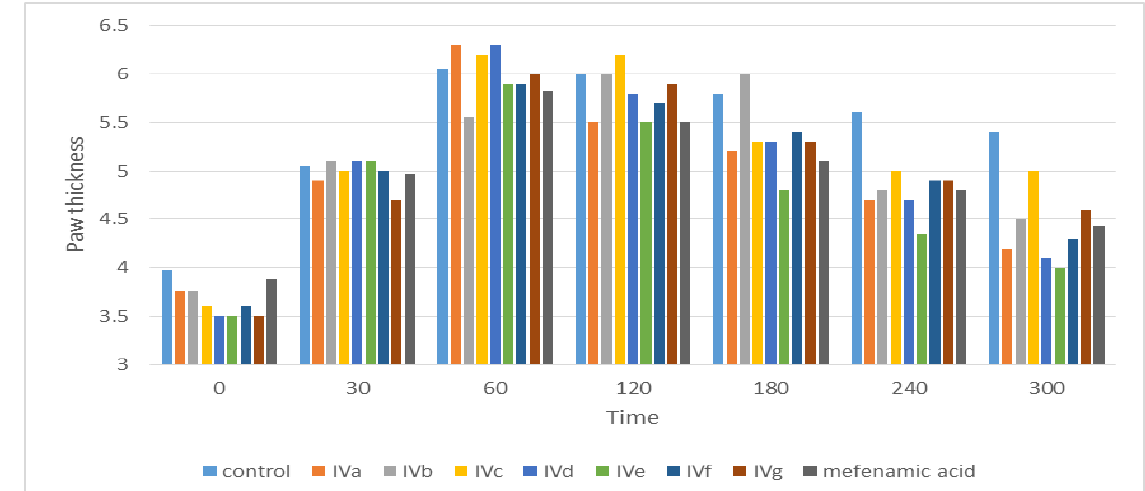
Figure (1) Effect of mefenamic acid, dimethyl sulfoxide, compounds IVa-g on egg-white induced paw edema in rats. Results are expressed as mean ± SEM (n = 6 for each